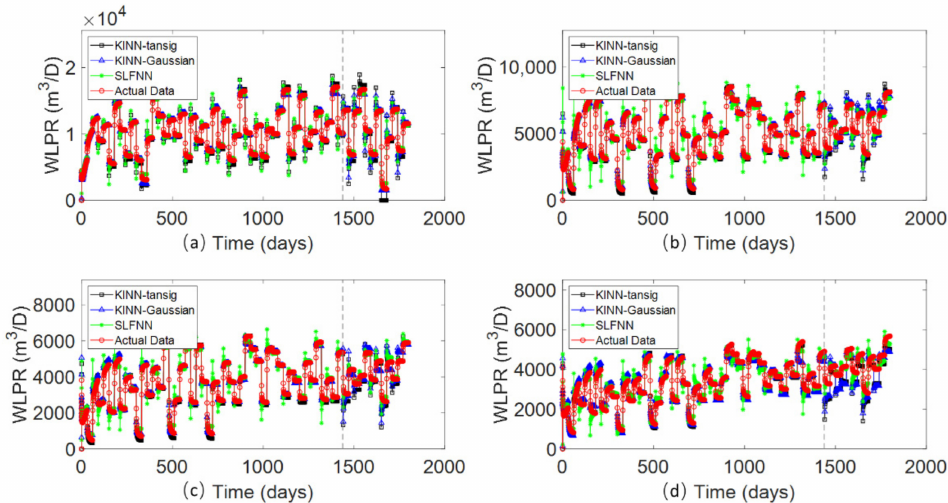
Figure 10. History matching results of the braided river reservoir case by KINN-tansig, KINN- Gaussian and SLFNN. The black line with squares is the result obtained by KINN-tansig method; the blue line with triangles represents the result gotten by the KINN-Gaussian method; the green line with stars is the results obtained by SLFNN; the red line with circles is the liquid production rate gotten by ECLIPSE; the grey vertical dashed line makes a separation of history matching period and the productivity forecast period: ( a ) P1; ( b ) P2; ( c ) P3; ( d )